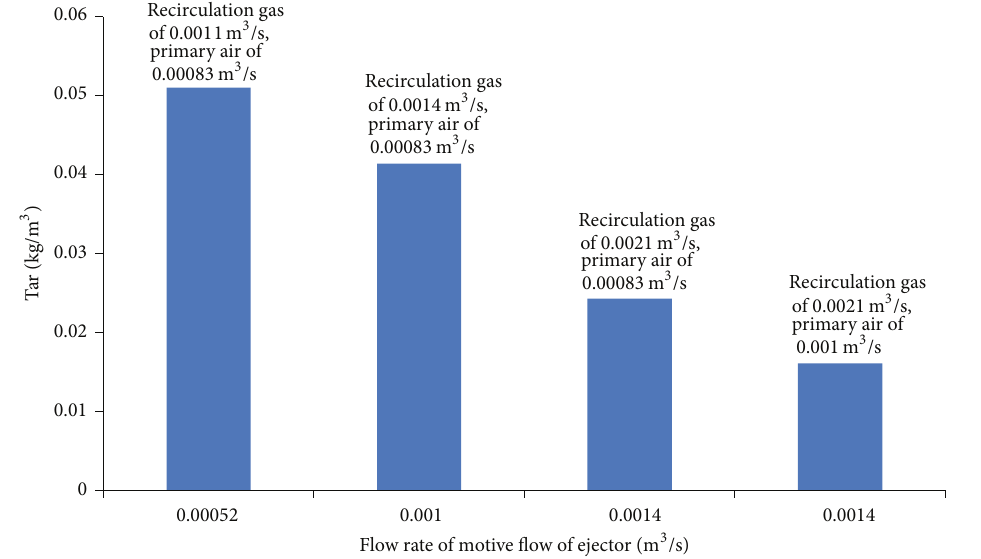
Figure 2: Tar content versus motive flow